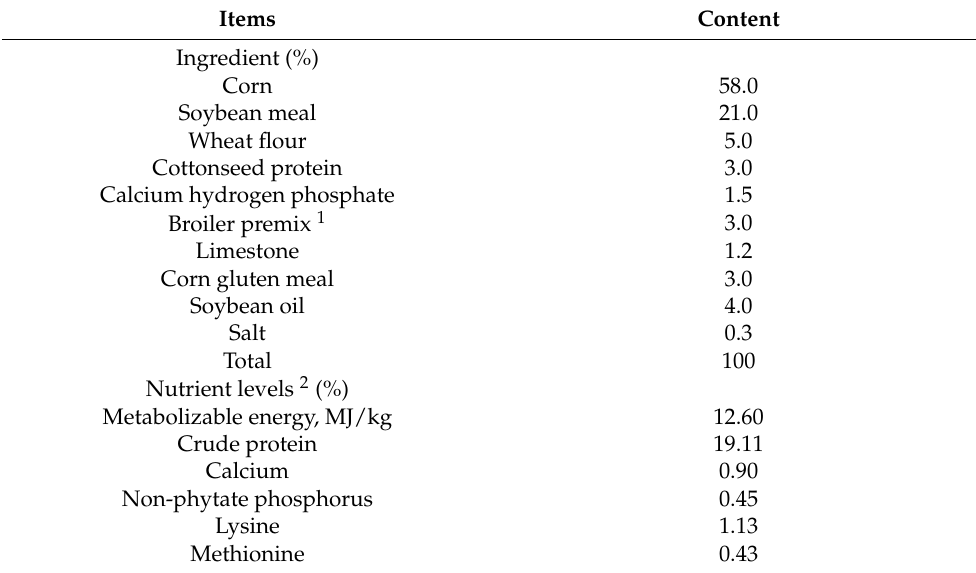
Table 1. Ingredient and nutrient composition of experimental